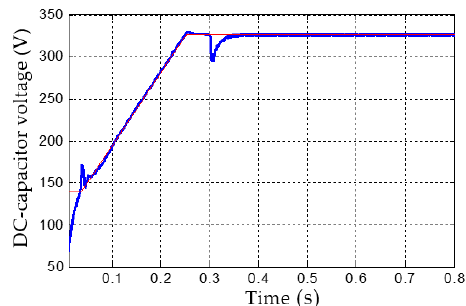
Figure 4. Evolution of the DC-capacitor voltage: prescribed (in red); real (in blue).